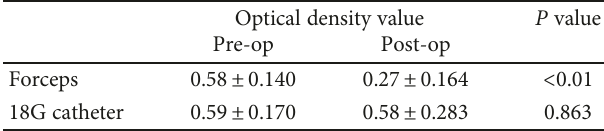
Table 1: The cell loss rate of the two delivery methods